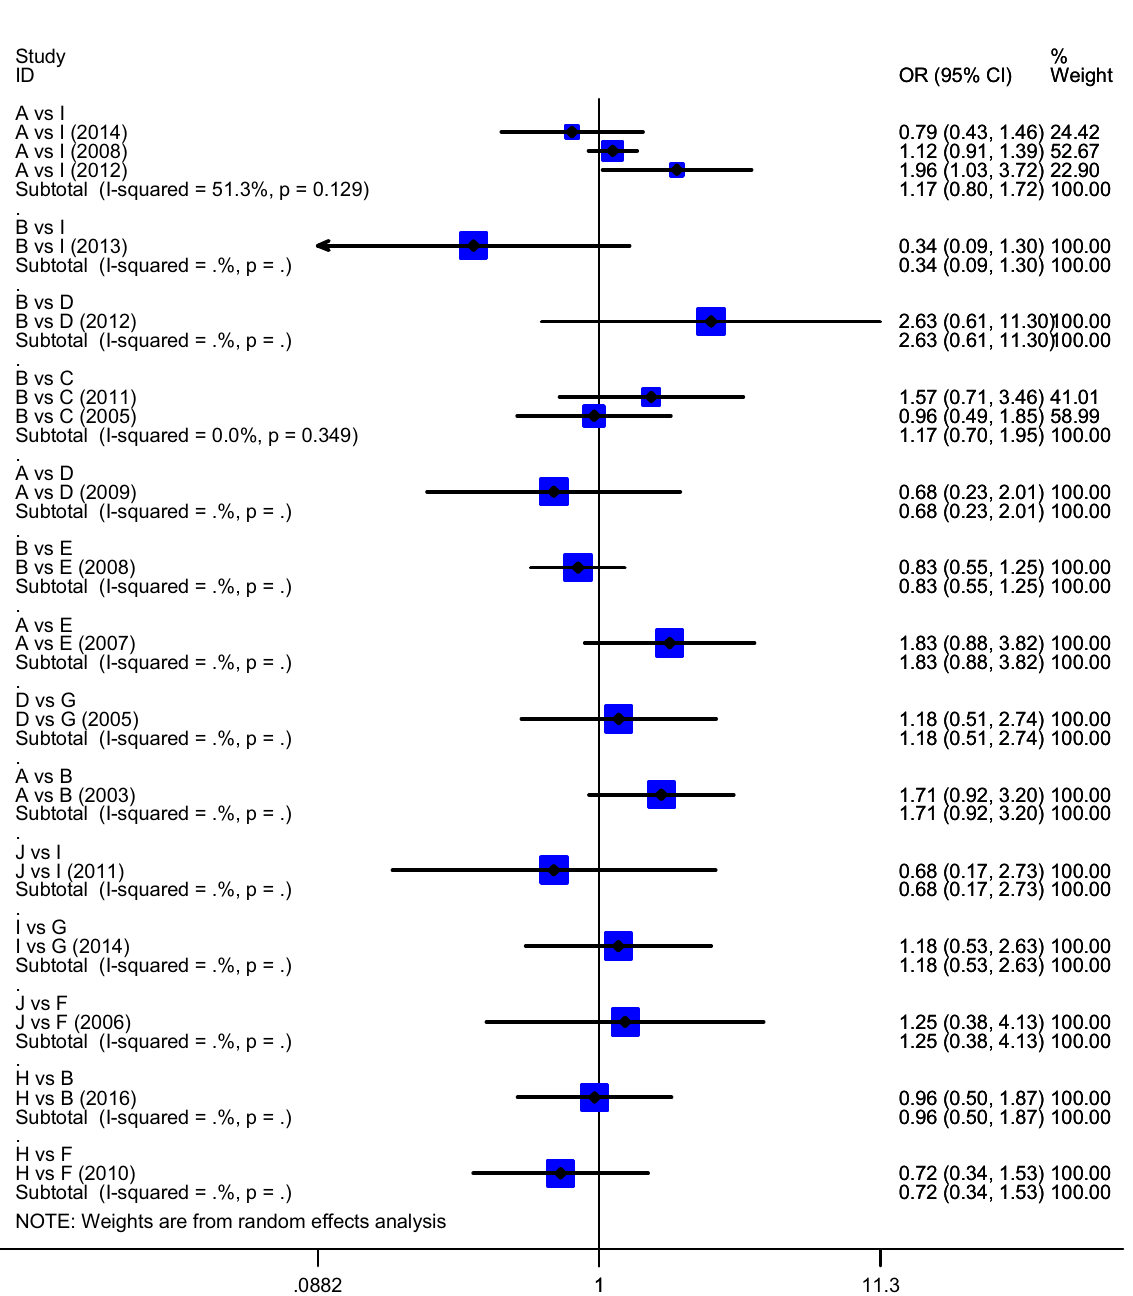
Figure 3: The forest plot of ORR for the fi rst - line chemotherapy regimens in treatment of advanced NSCLC. A = cisplatin + gemcitabine, B = carboplatin + gemcitabine, C = gemcitabine, D = carboplatin + paclitaxel, E = paclitaxel + gemcitabine, F = carboplatin + docetaxel, G = gemcitabine + vinorelbine, H = carboplatin + pemetrexed, I = cisplatin + pemetrexed and J = cisplatin +